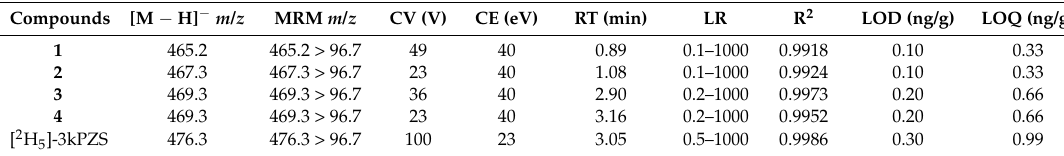
Table 1. Optimized UHPLC-MS/MS parameters for each analyte.